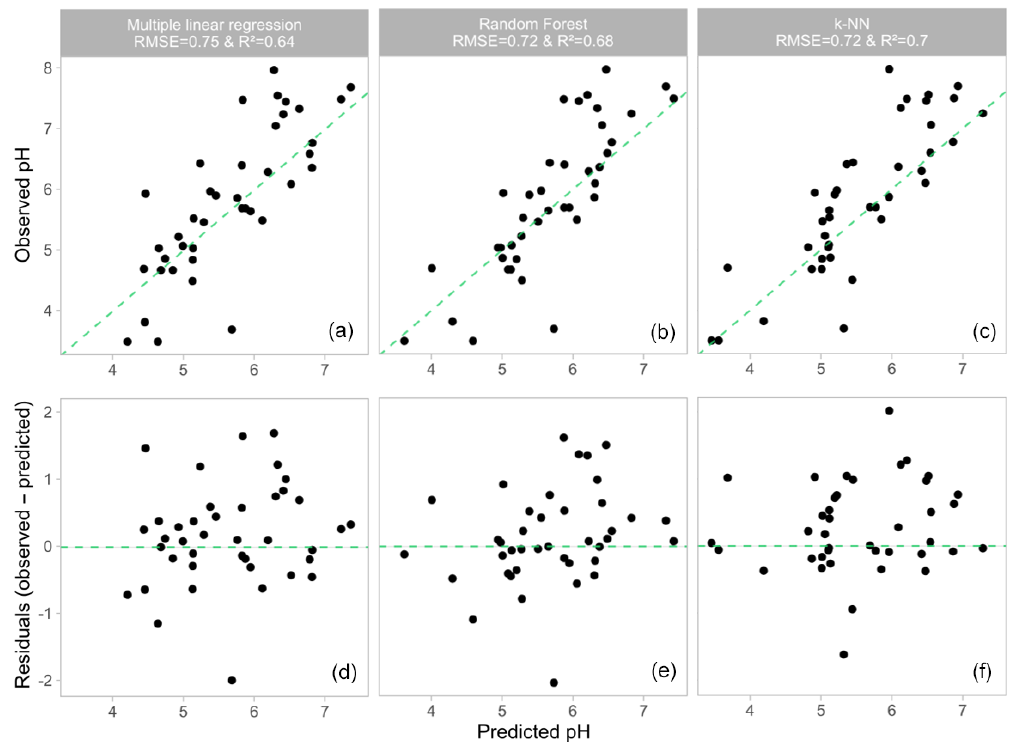
Figure 8. Results of the three different models tested to reconstruct the pH from 3-OH FA distribution: observed pH vs. predicted pH for (a) the multiple linear regression model, (b) the random forest model and (c) the k -NN method. The pH residuals plotted against the predicted pH for (d) the multiple linear regression model, (e) the random forest model and (f) the k -NN method.